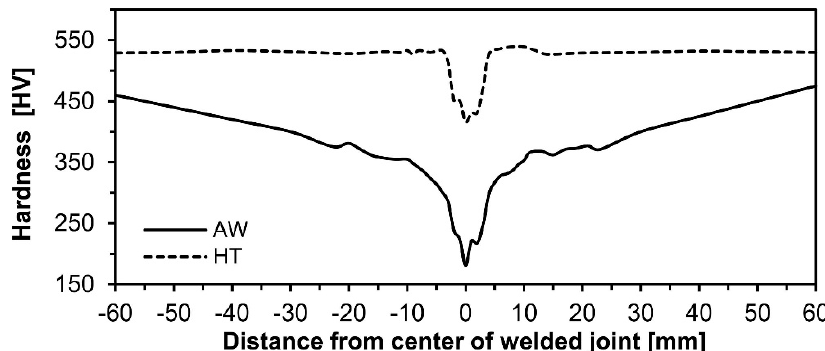
AW—after welding; HT—heat-treated.